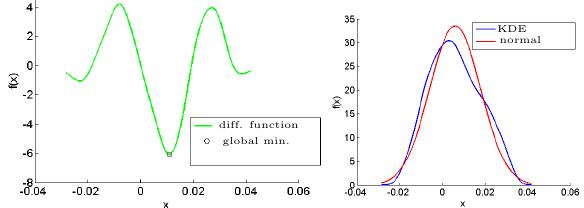
Figure 7. Characteristic deformation of the residual distribution of a roof surface caused by a dormer. An expected normal dis- tribution is taken as reference. Left: Difference function of both distributions with the according global minimum. Right: PDF is- sued from a KDE (blue) and its approximated normal distribution